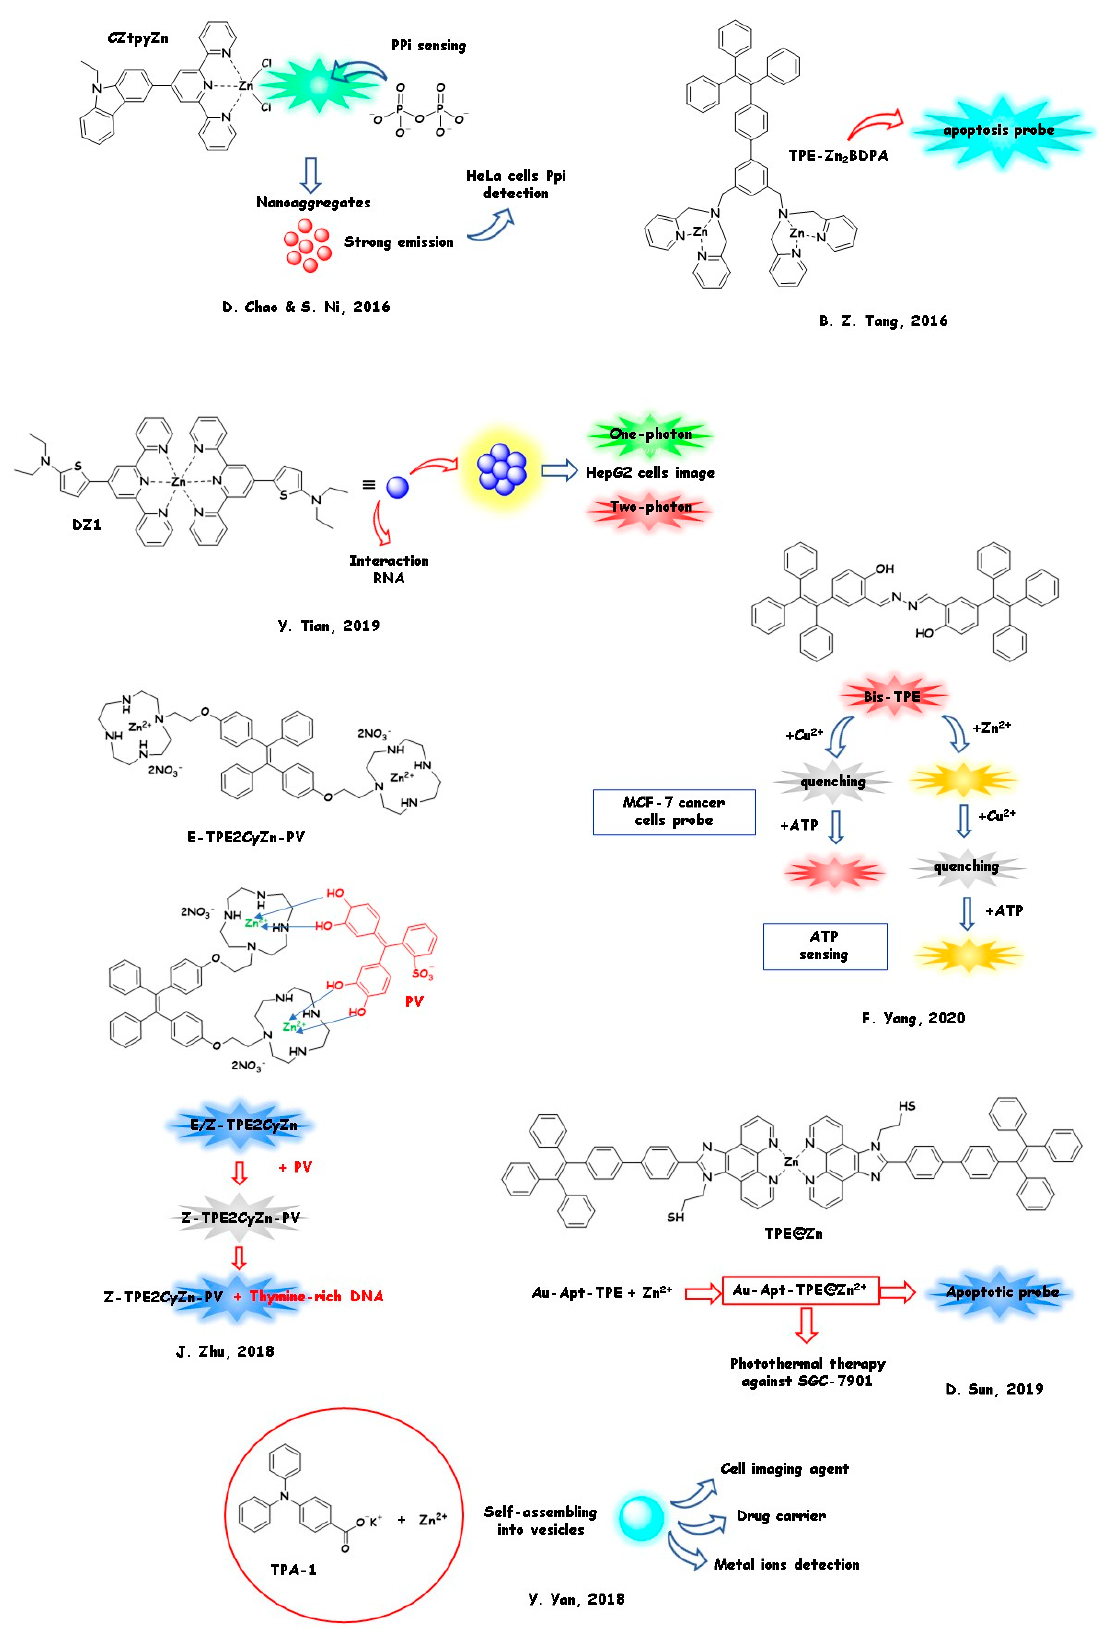
Figure 10. Structures and sensing/marking pattern of zinc-based AIE active biosensors/markers.